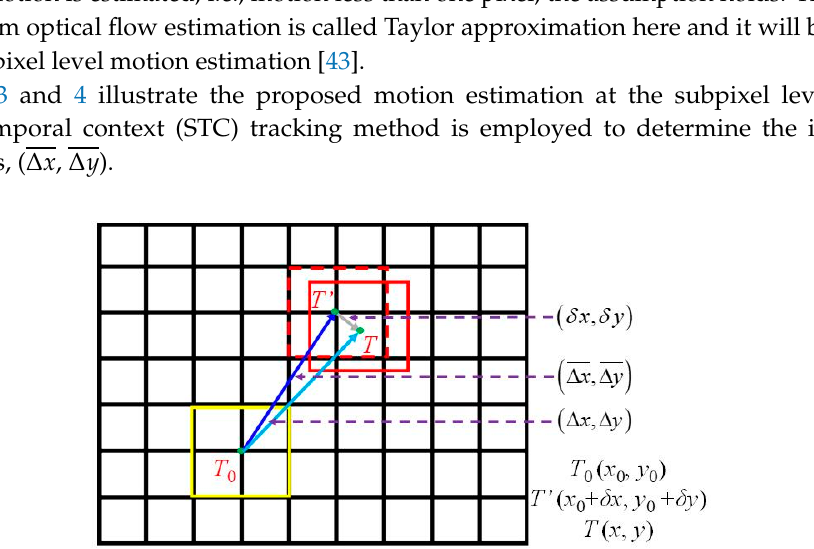
Figure 4. Flowchart of STC-based subpixel tracking using Taylor approximation. In Figure 3, the yellow, solid line box represents the original target location in the initial frame and the red, dashed line box represents the target recognized in the current frame using STC tracking, which has an accuracy at the subpixel level. Here the centers of the targets are used to represent their locations, i.e., T 0 and T’ . Assuming the real target in the current frame is the red, solid line box at location T , the true displacements are ( Δ x , Δ y ). Then, the displacements ( x Δ ,